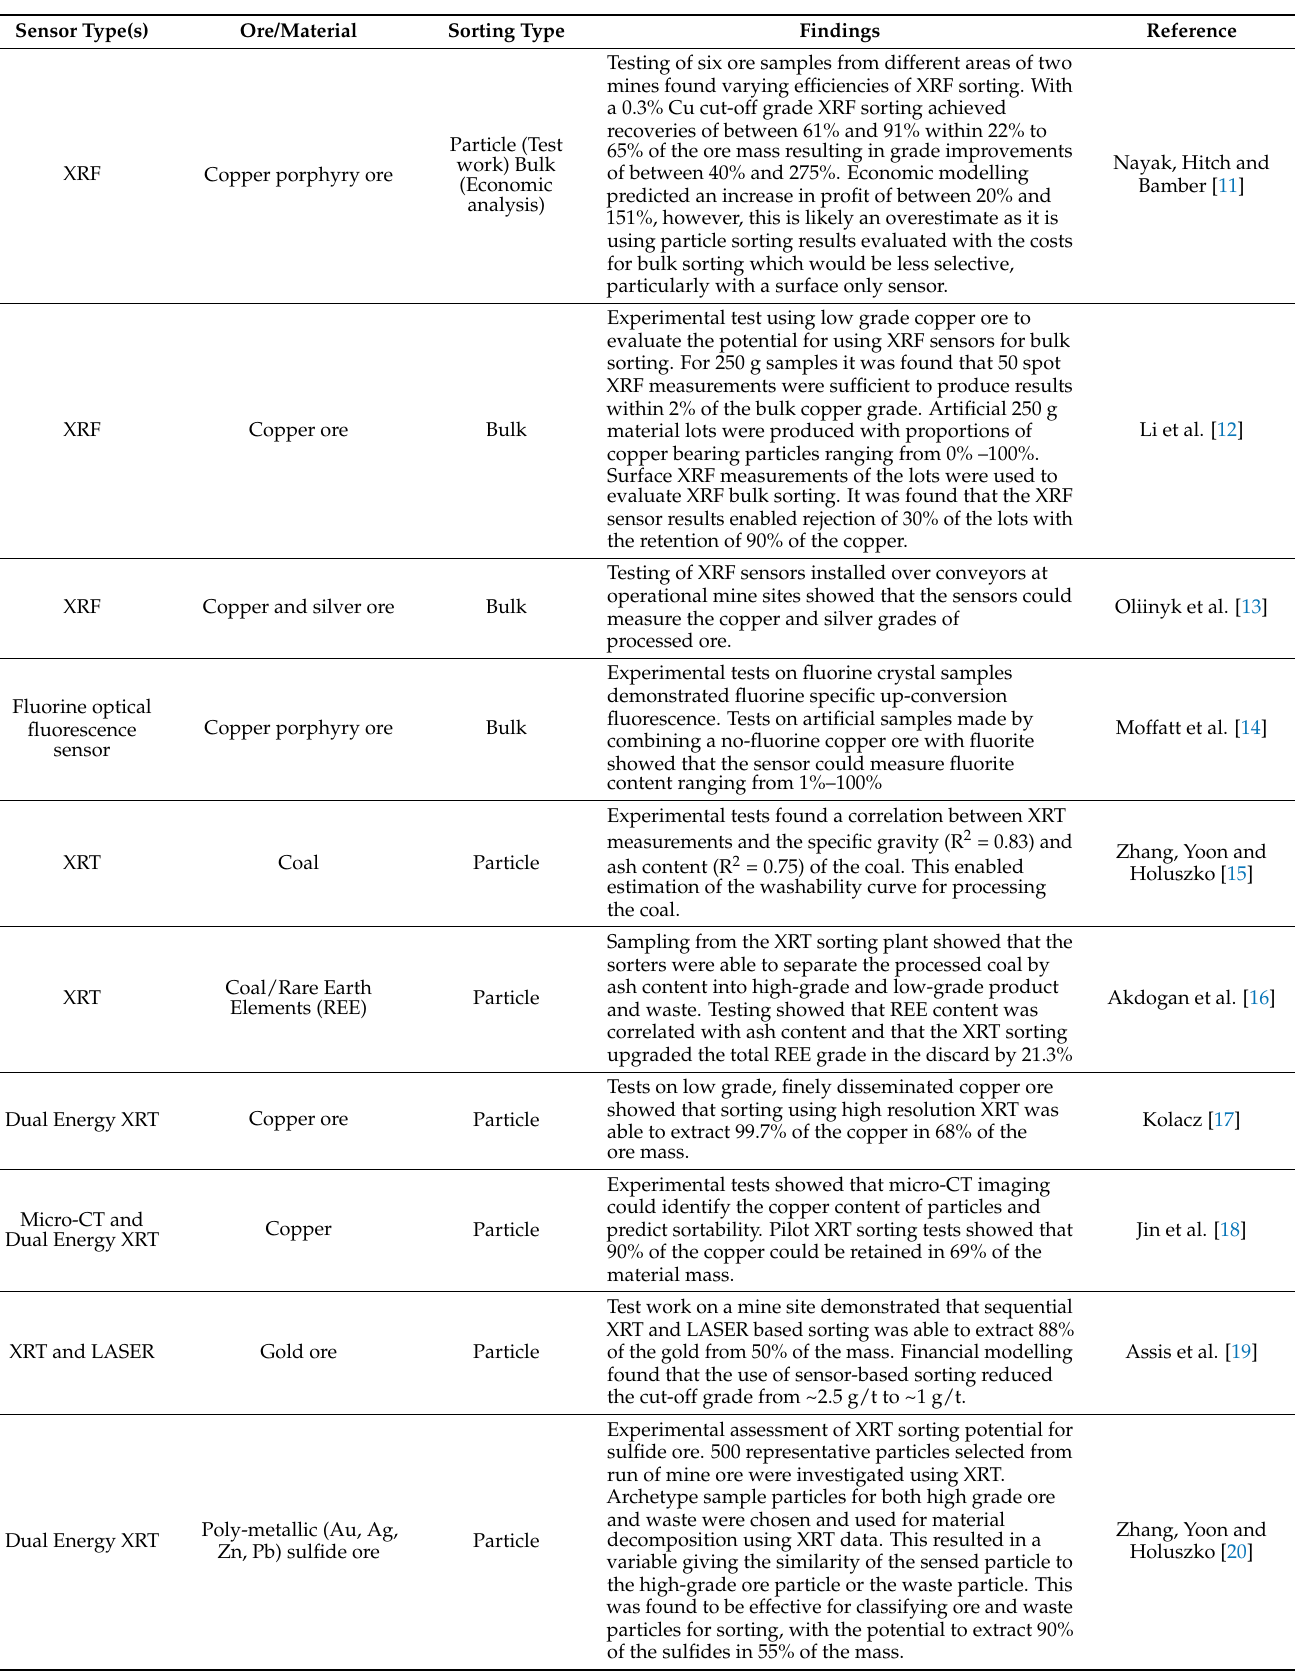
Table 2. Summary of recent sensor-based sorting